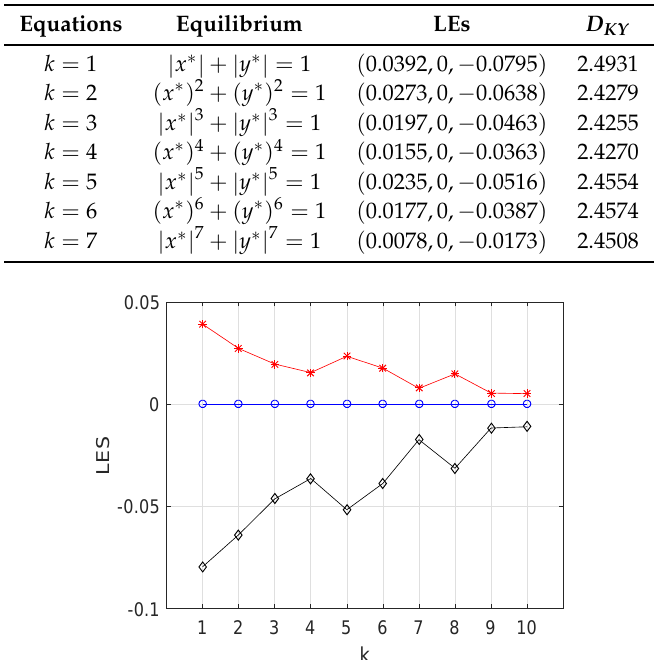
Figure 3. The graph of the three Lyapunov exponents of system (3) for the value of k from 1 to